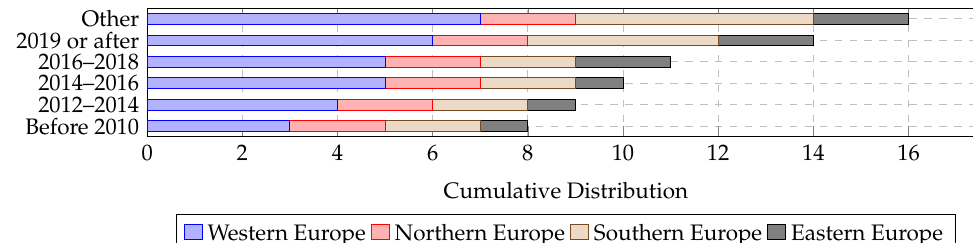
Figure 2. Starting year of GIS model use by region ( N = 16 cities).